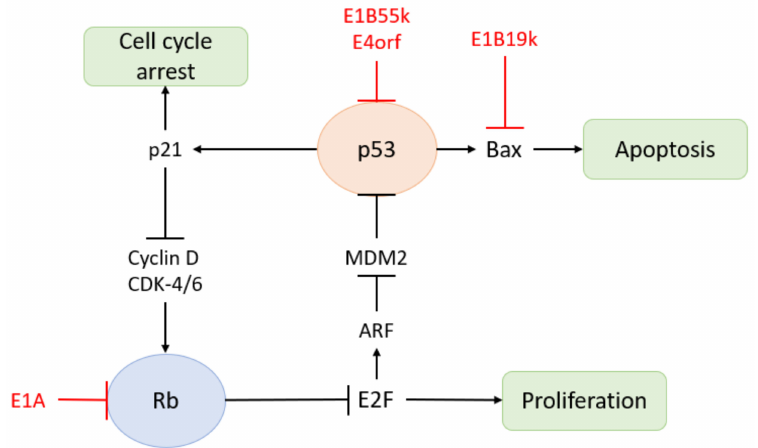
Figure 5. Proteins of HAdV can inhibit Rb pathway and p53